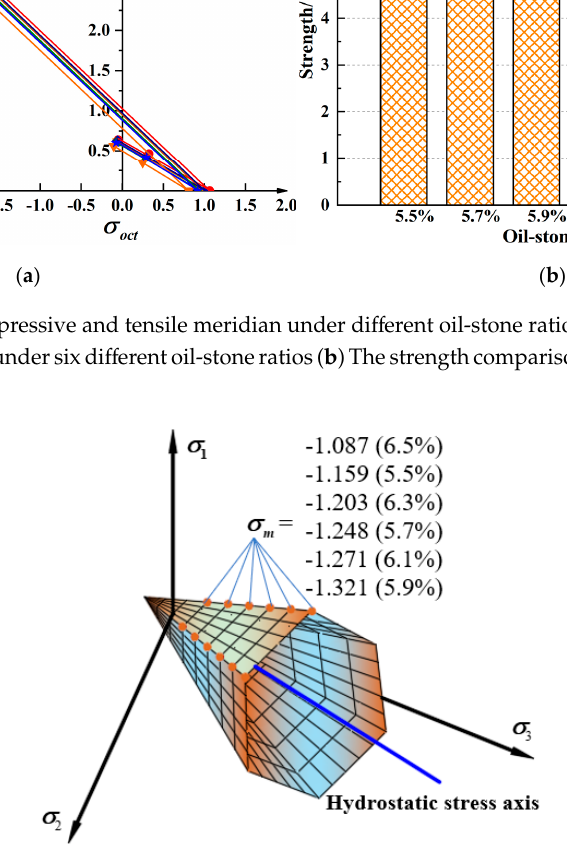
Table 8. Test results of asphalt mixture under different temperatures.